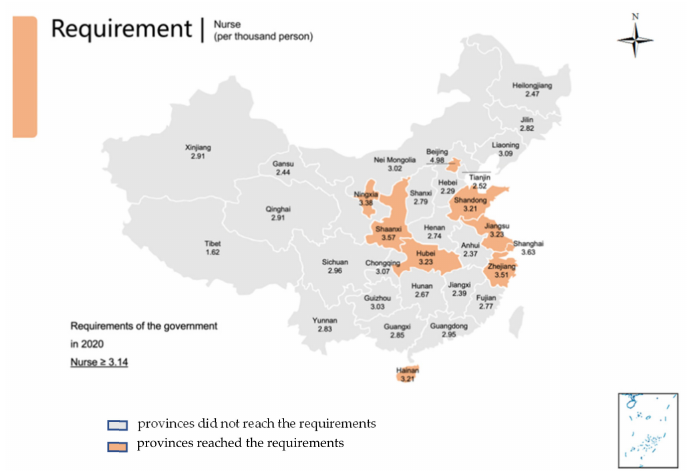
Figure 7. Provinces reached the requirements of the number of nurses in 2020 by the government; Provinces did not reach that requirement.